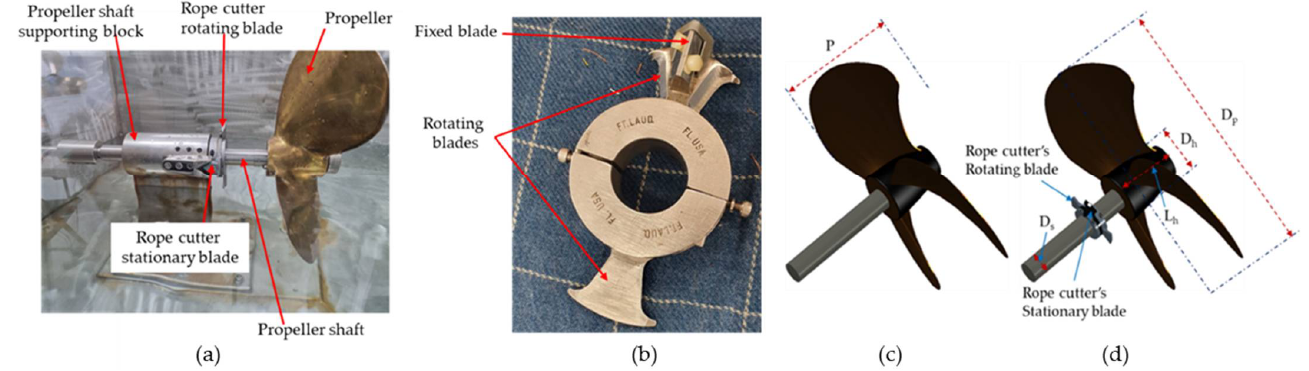
Figure 2. Actual propeller with rope cutter installed ( a ): actual geometry of the rope cutter ( b ); 3D model of the propeller without rope cutter ( c ); and with rope cutter ( d ).